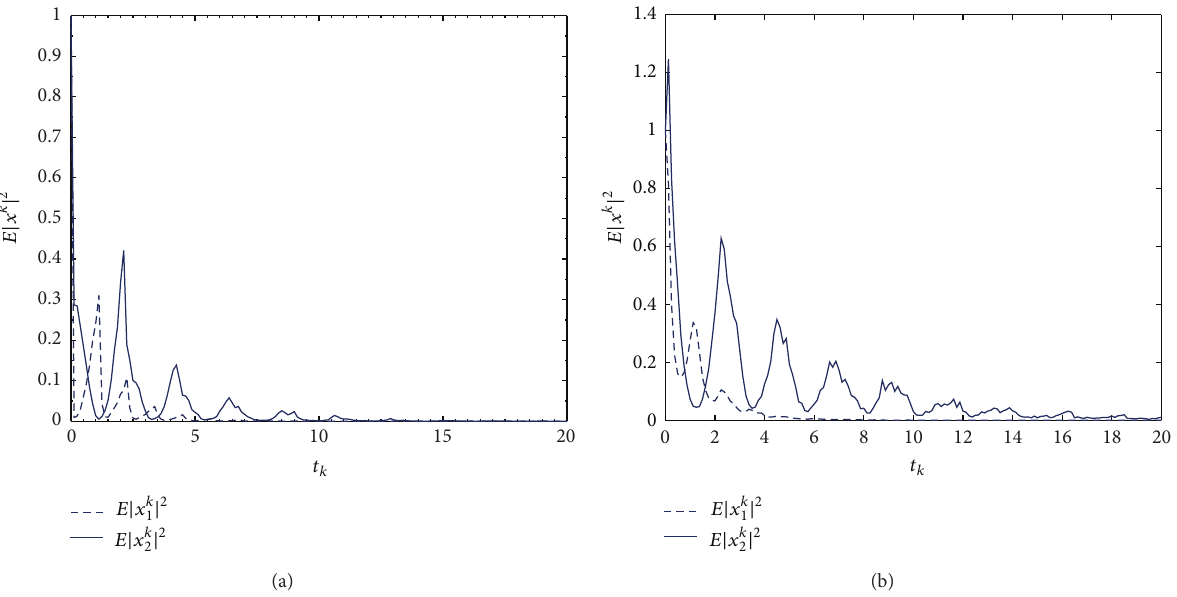
Figure 1: MS stability of the numerical solutions to (45) with ℎ = 0.125 ; (a) EM, (b) SSBE.